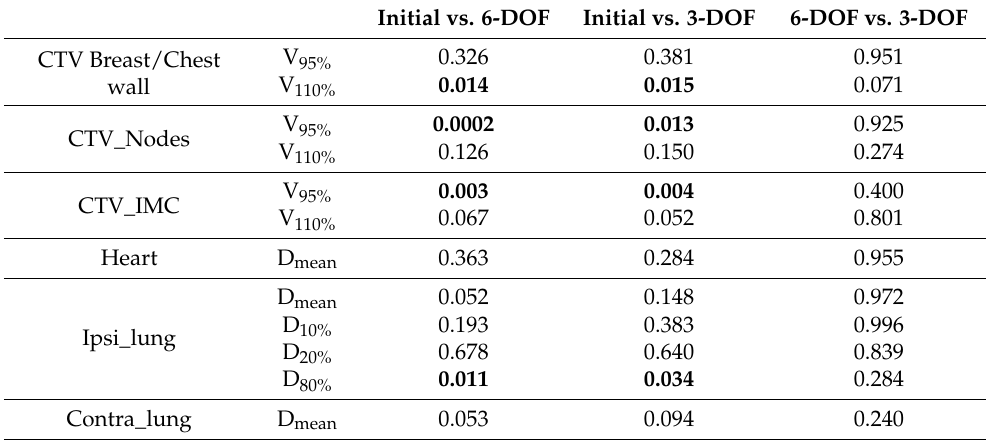
Table 3. p -values for differences in dose metrics between the indicated plans. Pairwise comparisons performed between the initial plan and those obtained with the 3-DOF and 6-DOF, between the plans obtained with the two matching techniques. Values are bolded where p <